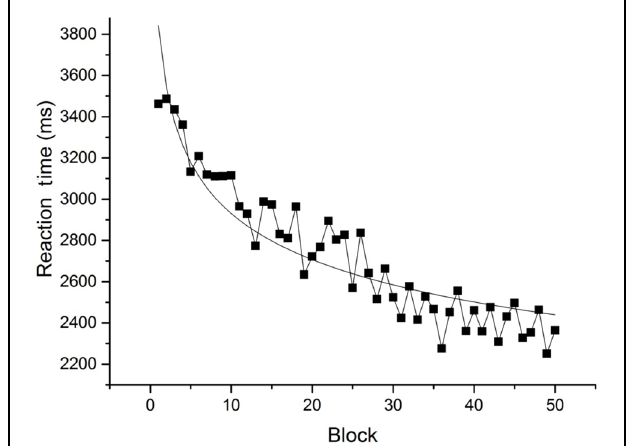
FIGURE 3 | Mean RT for each block of trials. The smooth line is the best-fit power function (RT = 342.30 + 3500 × block − 0 . 13 , r 2 = 0.86, and rmsd = 99.68).